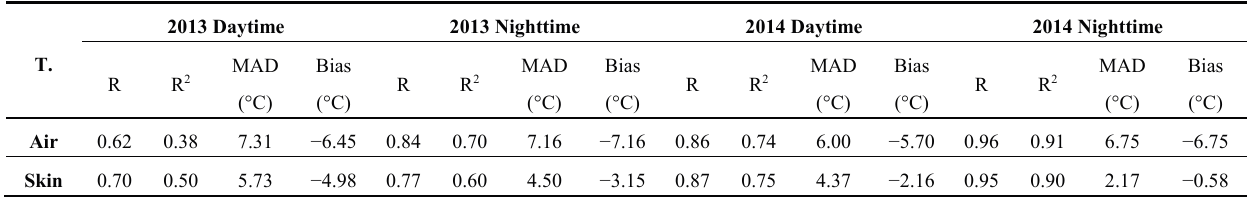
Table 3 . R and R 2 correlation coefficient values, MAD, and biases between VIIRS LST daytime and nighttime views for the bare land pixel, T-skin, and T-air at CREST-SAFE for winters 2013 and